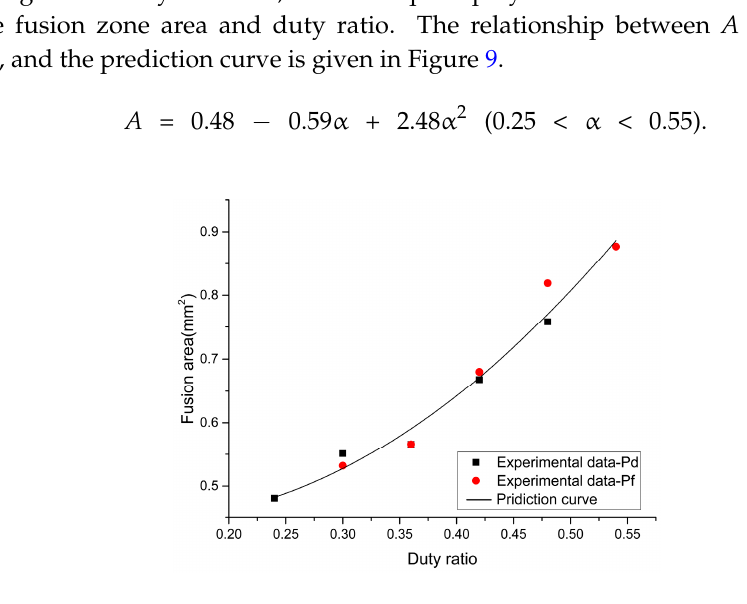
Figure 9. Relationship between fusion zone area and duty ratio.